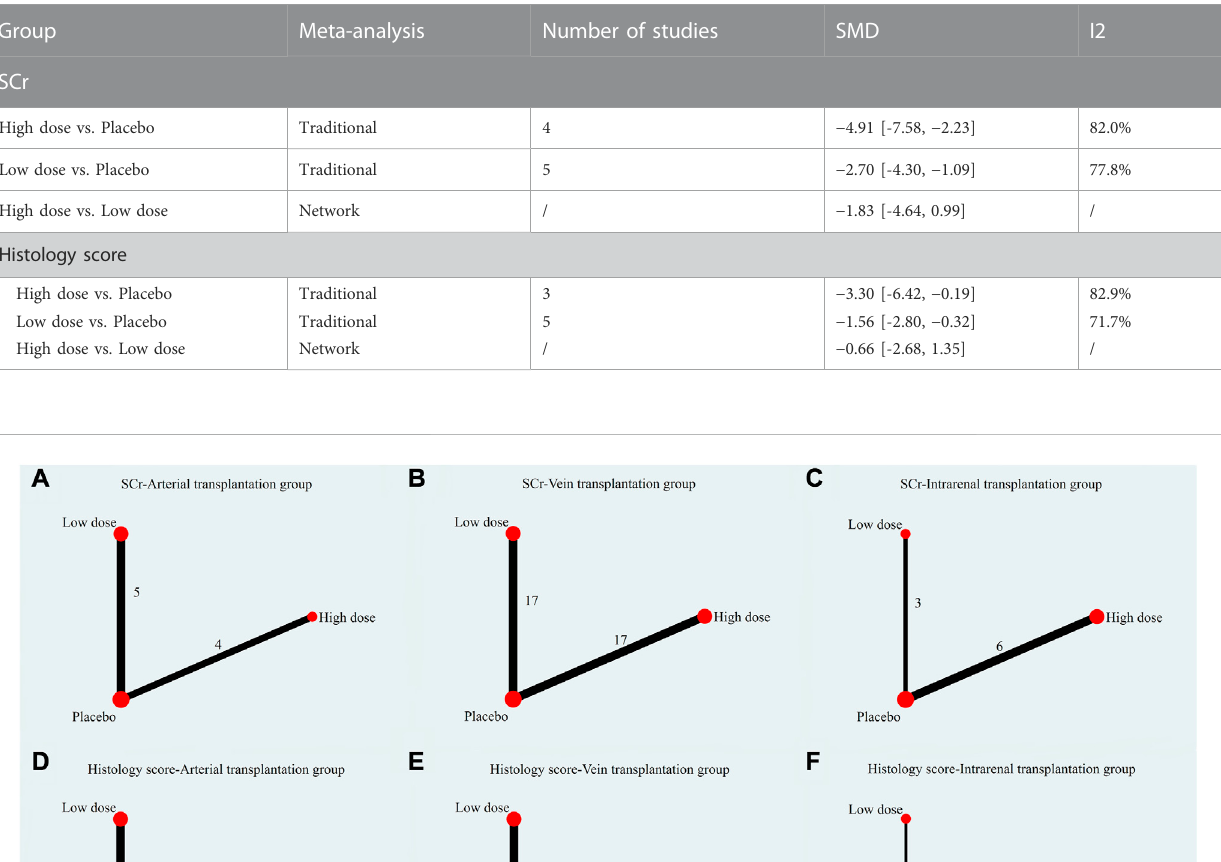
TABLE 3 Comparison of different doses in artery transplantation group.